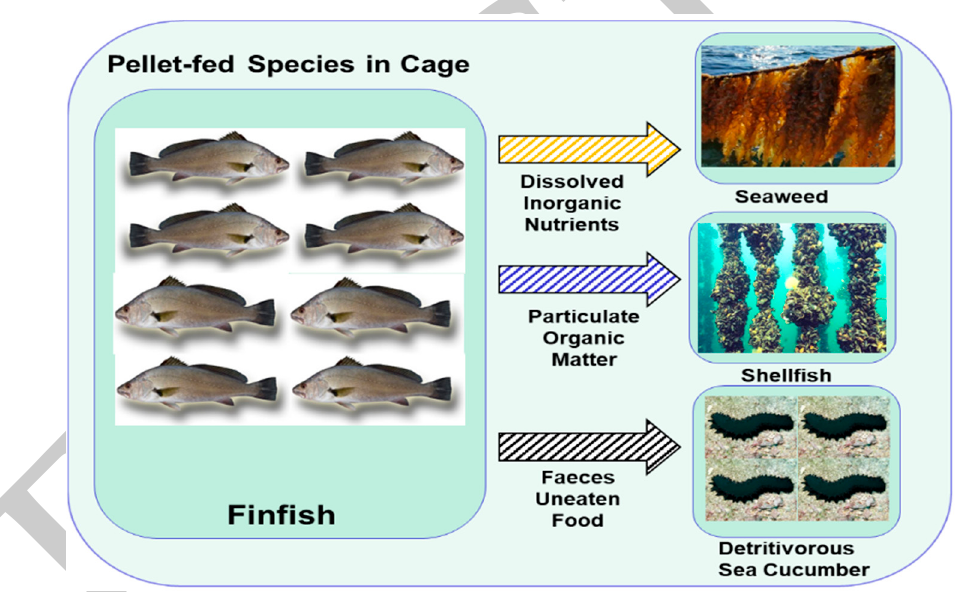
Figure 2. Schematic illustration of aquaculture based on the principle of enhanced complementarity via trophic interactions amongst combined species. In IMTA, water flow supports the multi-trophic interactions. This principle enables the utilization of the waste of one aquaculture subsystem as a food source for another. For instance, finfish species are reared based on pellet feeding. Extractive shellfish species utilize dissolved organic matter, and seaweed extracts the inorganic content: feces and uneaten food consumed by detritivorous sea cucumber species.